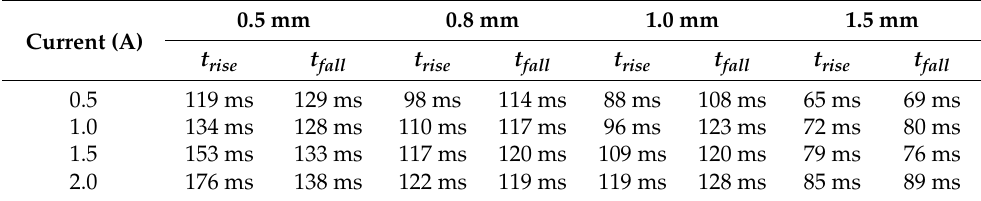
Figure 13. Response time of the MR valve under different radial damping gaps: ( a ) 0.5 mm, ( b ) 0.8 mm, ( c ) 1.0 mm, ( d ) 1.5 mm. Table 2. Response characteristic of the annular-radial-orifice flow MR